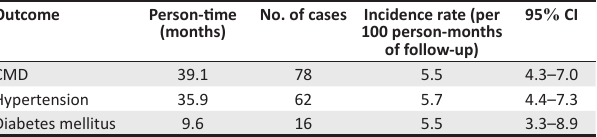
FIGURE 1: Kaplan–Meier time estimates to occurrence of cardiometabolic disease (a), hypertension (b) and diabetes mellitus (c). TABLE 3: Incidence rates for hypertension and diabetes mellitus among study participants who had been on antiretroviral treatment for more than 1 year in Lesotho (2011–2015).